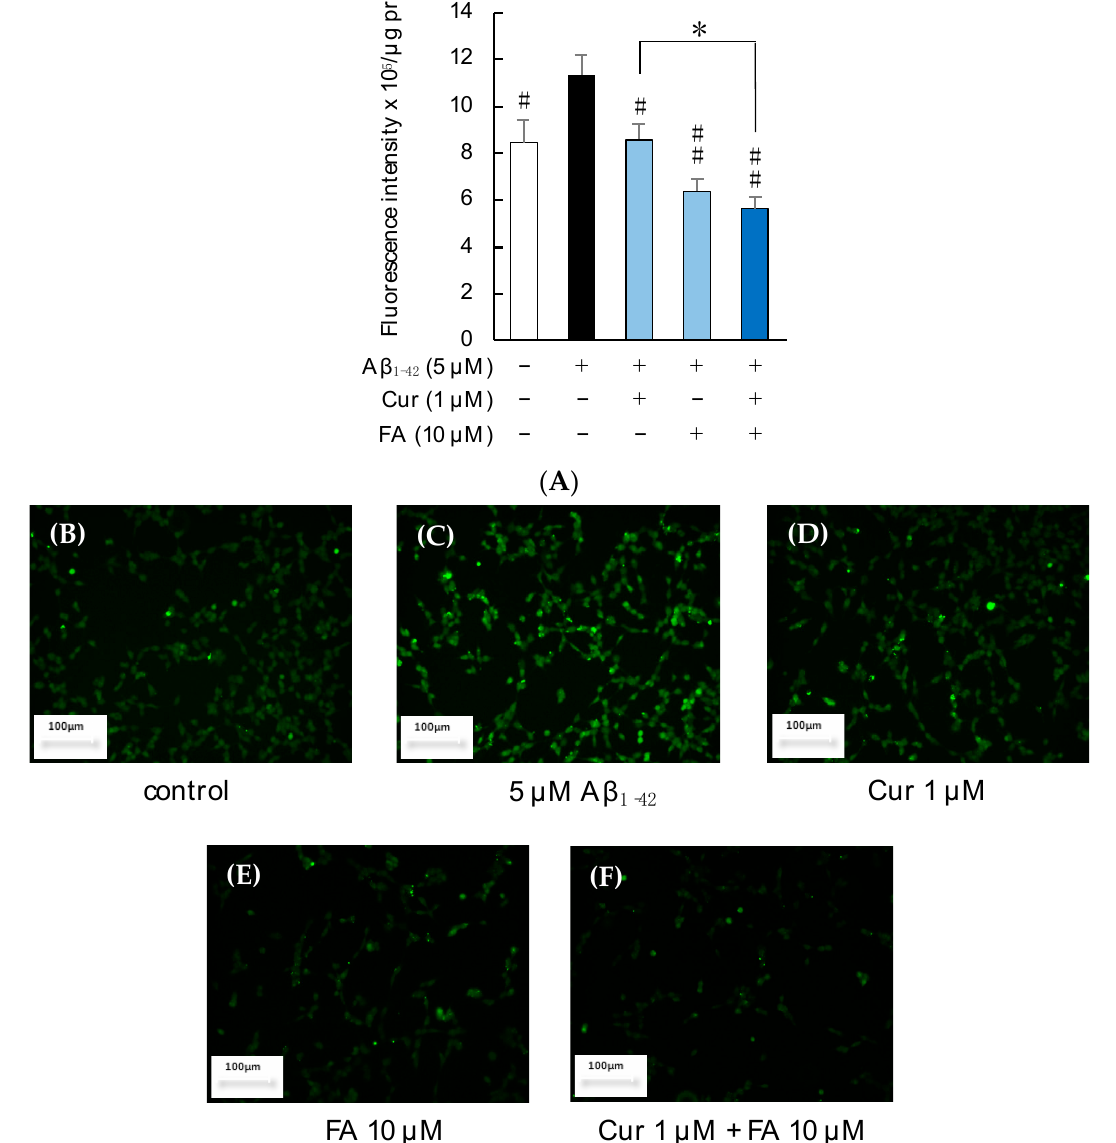
Figure 5. Effect of Cur, FA, or a combination of both on ROS generation in A β 1 – 42 -stimulated SH-SY5Y cells. The generation of ROS in A β 1 – 42 -stimulated SH-SY5Y cells was evaluated using 2 ′ ,7 ′ - dichlorodihydrofluorescein diacetate (CM-H 2 DCFDA). ( A ) The generation of ROS in SH-SY5Y cells exposed to 5 μ M A β 1 – 42 and treated with A β 1 – 42 + 1 μ M Cur, A β 1 – 42 + 10 μ M FA or A β 1 – 42 + Cur + FA. ( B – F ) Fluorescence microscopic images in SH-SY5Y cells were acquired using an inverted fluores-